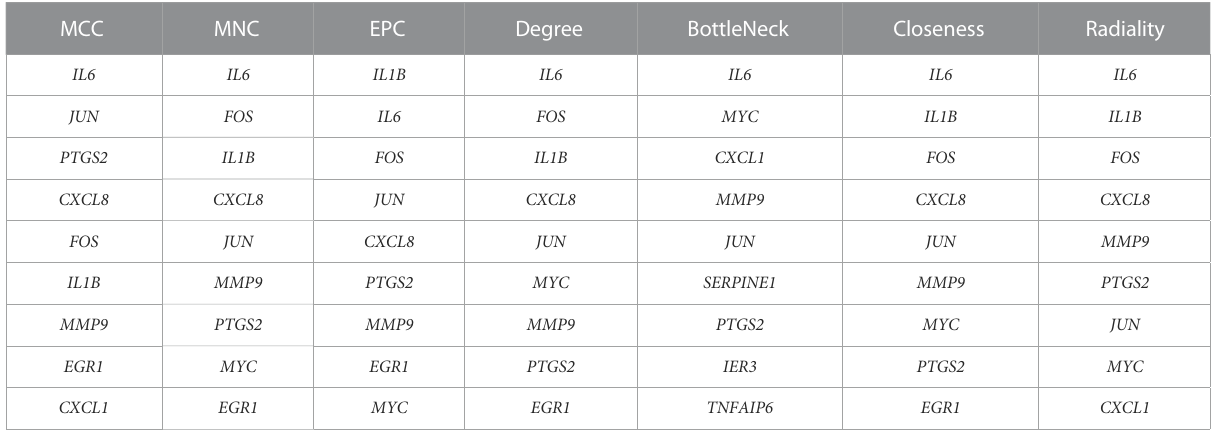
TABLE 2 List of the top 9 genes ranked by 7 algorithms in cytoHubba. MCC MNC EPC Degree BottleNeck Closeness